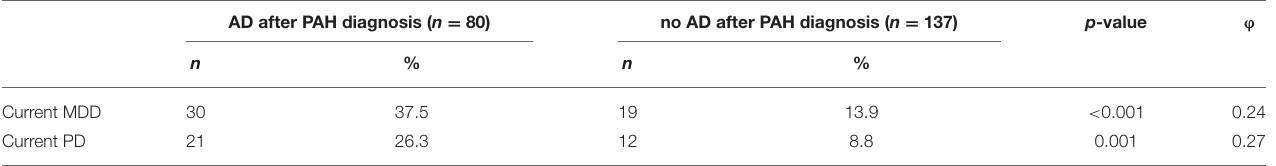
TABLE 2 | Prevalence of MDD and PD in patients with and without former AD. AD after PAH diagnosis ( n =